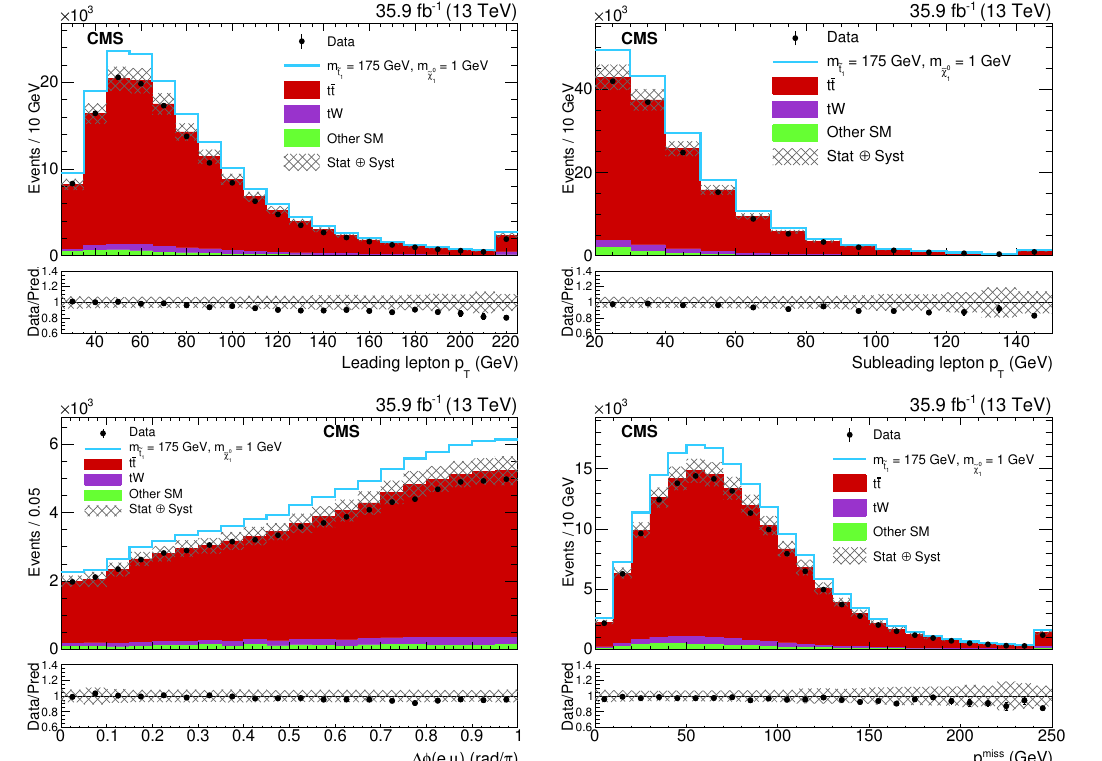
0.1 0.2 0.3 0.4 0.5 0.6 0.7 0.8 0.9